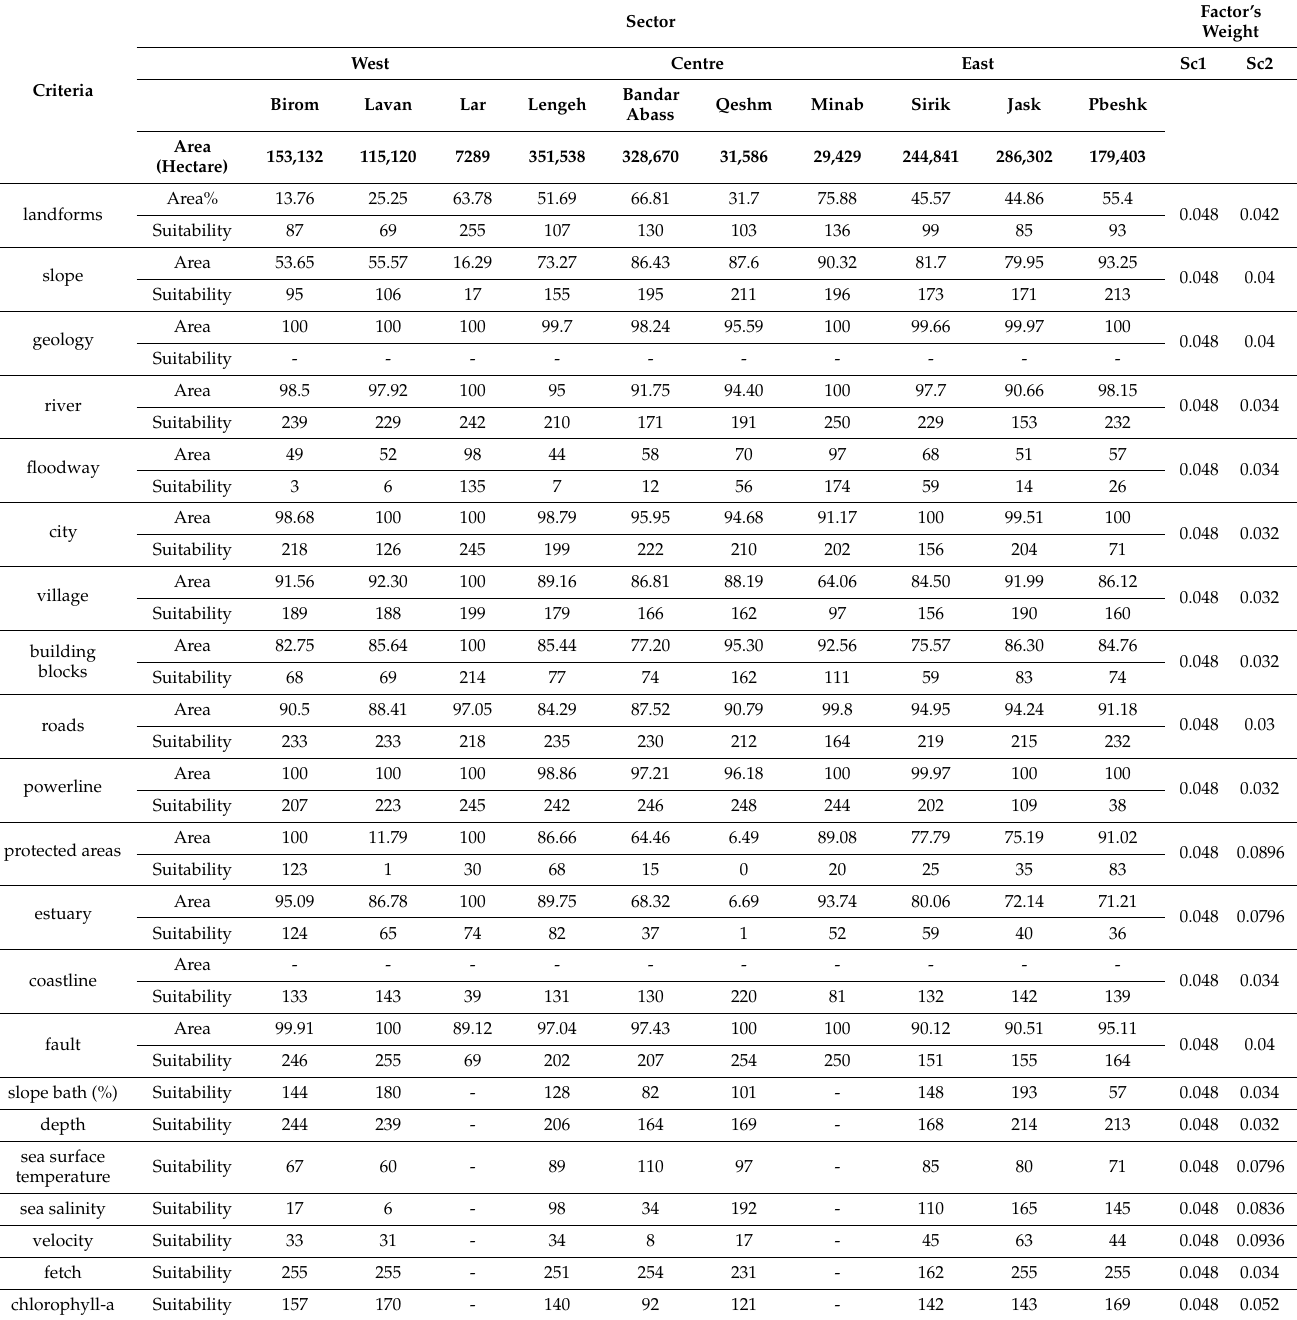
Table 3. Determining the remaining area from the region and the percentage changes after applying the